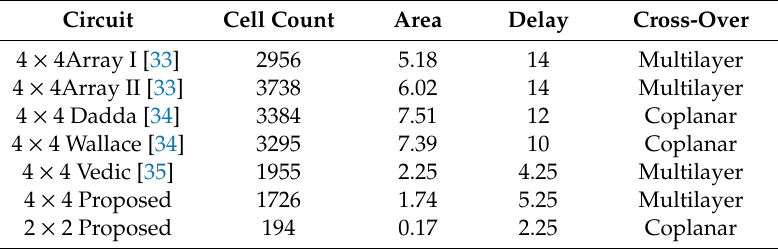
Table 4. Comparison of QCA